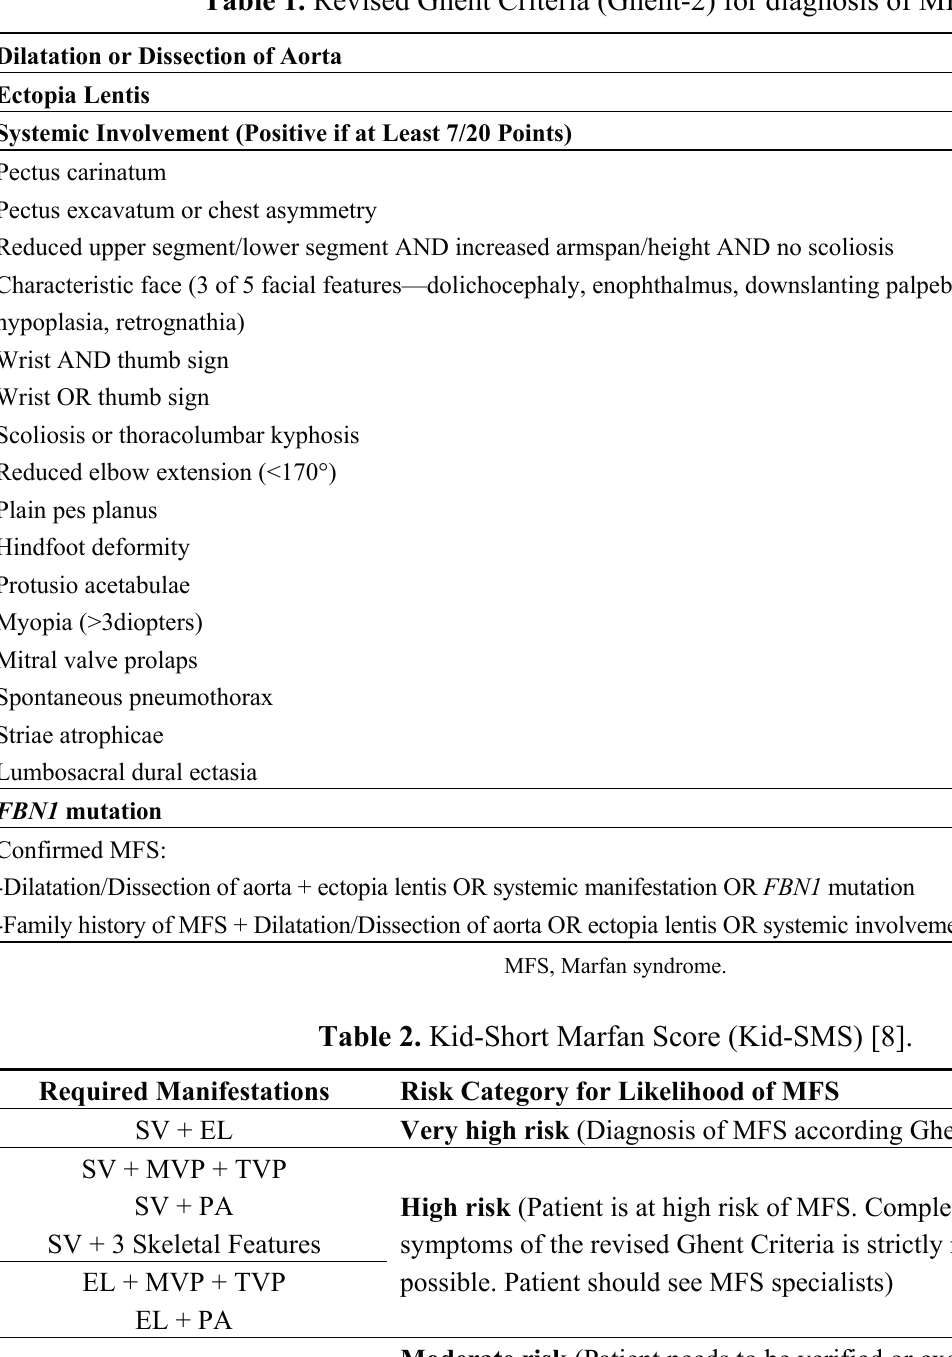
Table 1. Revised Ghent Criteria (Ghent-2) for diagnosis of MFS [7].